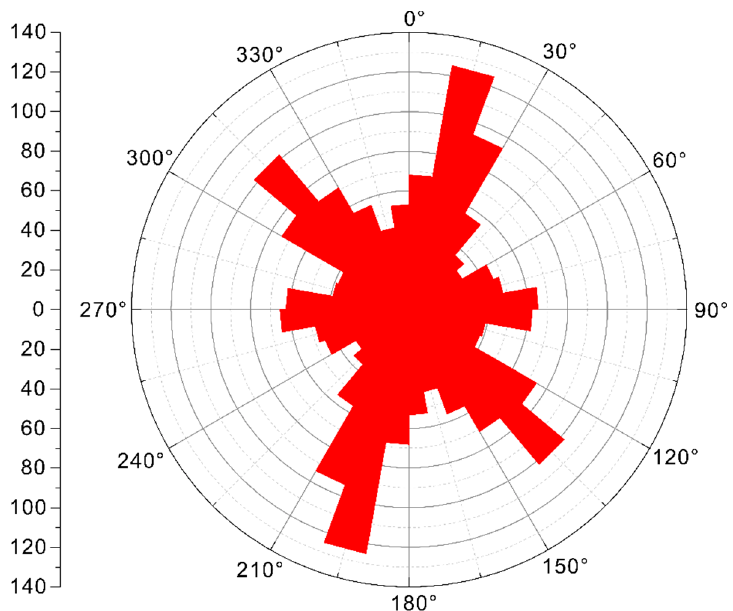
Figure 4. Tectonic fractures in outcrops. ( a ) Fractures are developed with a height of several meters on the cross-section. ( b ) Fractures are developed within the rock formation with a height of a few tens of centimeters. ( c ) Fractures show mutual crosscutting relations on the horizontal plane where Set C arrests Set D.